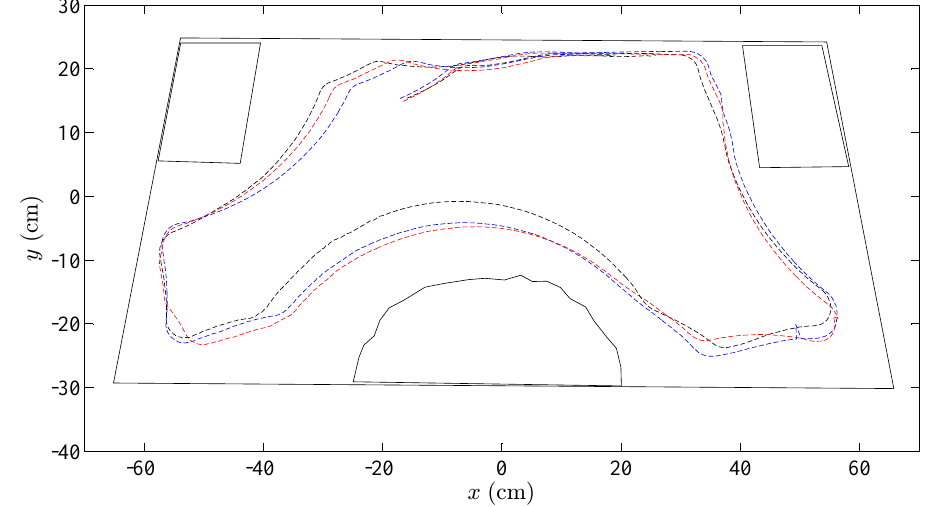
Figure 13. Trajectories of the robots controlled by the wall following algorithm. The black dashed line is the discrete-time strategy; the blue dashed line represents the event-based strategy with ¯ e = 10%; and the red dashed line is the event-based strategy with ¯ e =